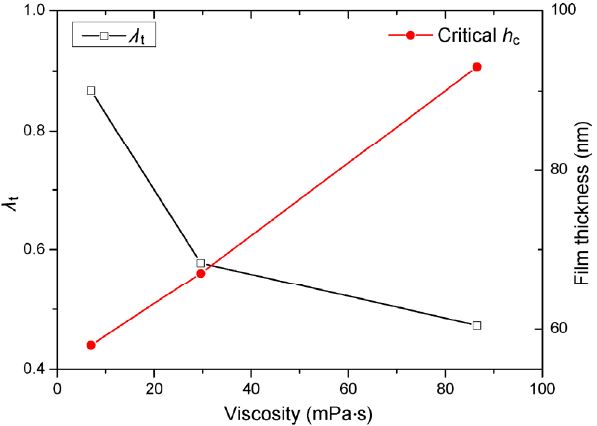
Fig. 7 Changes of critical filmthickness and the parameter λ t